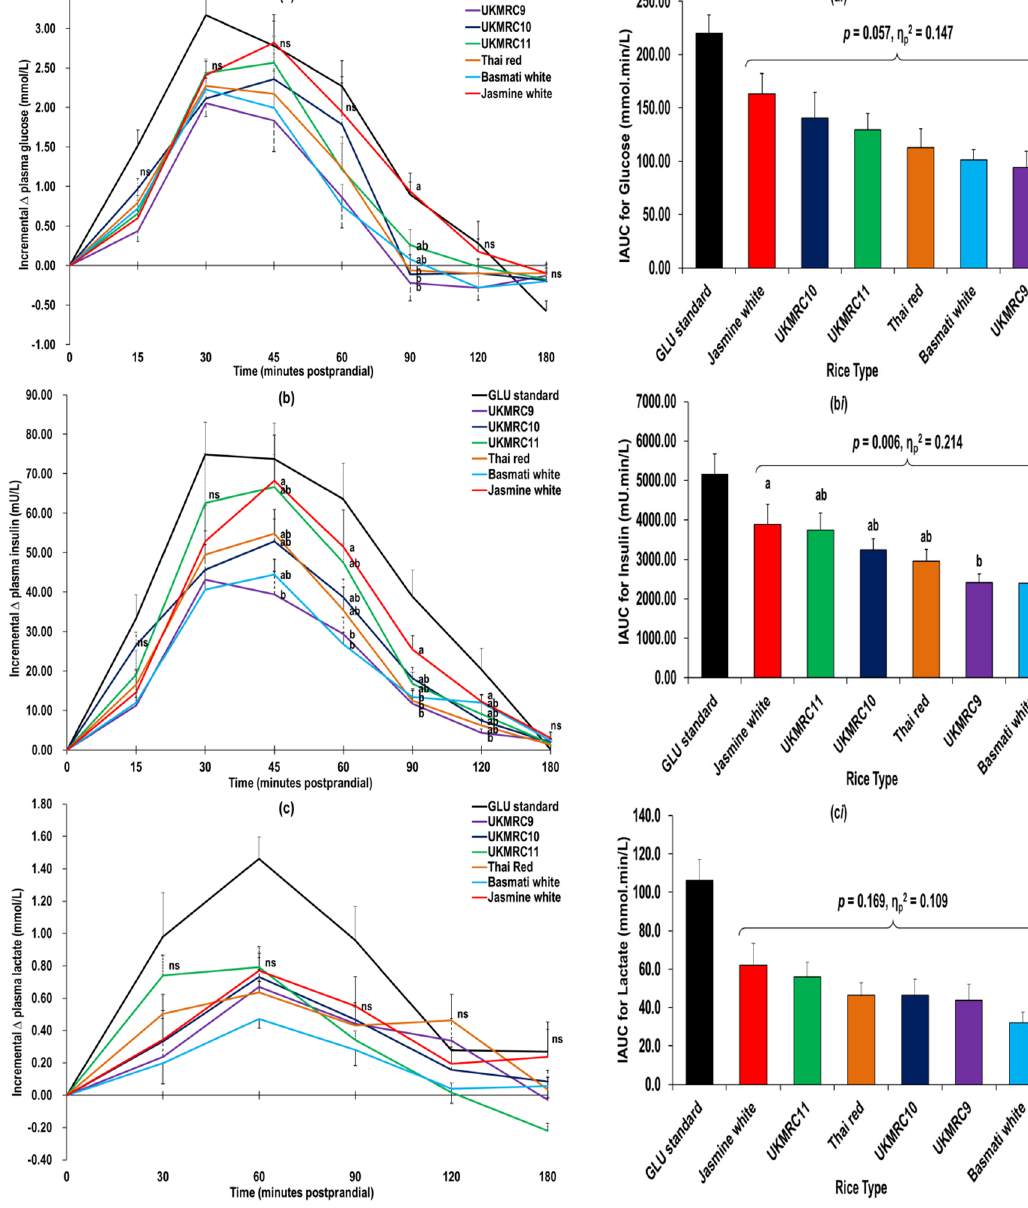
Figure 1. Baseline ‐ adjusted trends (mean ± SEM) in postprandial plasma ( a ) glucose; ( b ) insulin and ( c ) lactate responses for six test rice and glucose standard, and incremental area ‐ under ‐ the ‐ curve (IAUC) for postprandial ( a i ) glycaemia; ( b i ) insulinaemia and ( c i ) lactataemia. § Mean values bearing the same alphabets were not significantly different ( p > 0.05, univariate analysis of variance followed by Tukey’s post hoc test, ns = not significant); η p2 = partial eta ‐ squared, 0.01, 0.06 and 0.14 were used to denote small, moderate and large differences in measured outcomes, respectively.